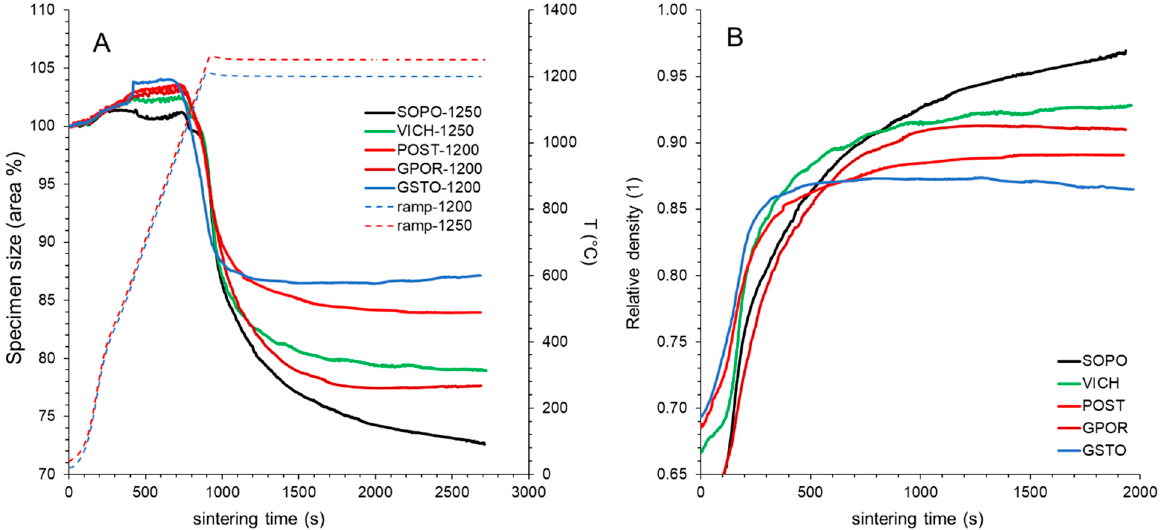
Figure 3. Firing behavior by HSM data ( in-situ experiments): ( A ) specimen size vs. total sintering time; ( B ) relative density vs. time from the densification start.